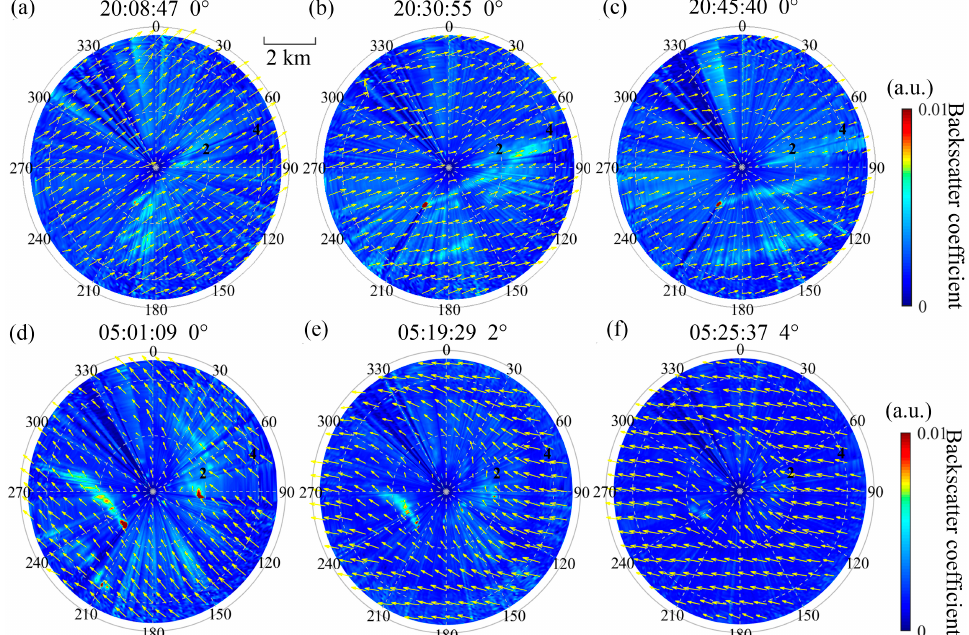
Figure 2. Horizontal scanning results of backscatter coefficient and two-dimensional wind vector for 27 March 2021. ( a – c ) Pollution emission episode detected with fixed elevation of 0° at night. ( d – f ) A typical pollution emission episode detected with elevations of 0°, 2°, and 4° in the early morning. The direction of vector indicates the direction of the wind speed, and the length of the vector represents the relative wind speed.